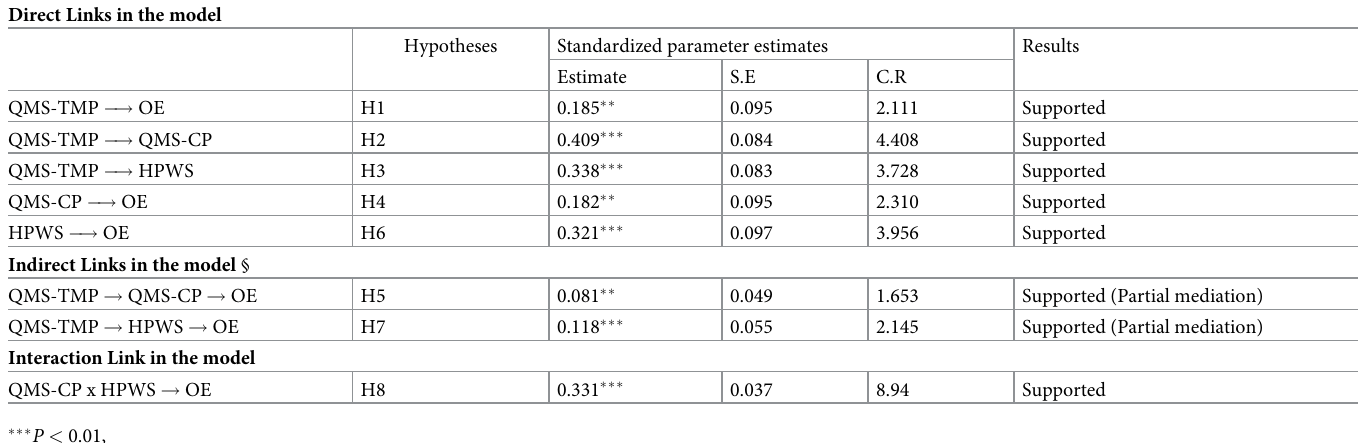
Table 6. Construct structural